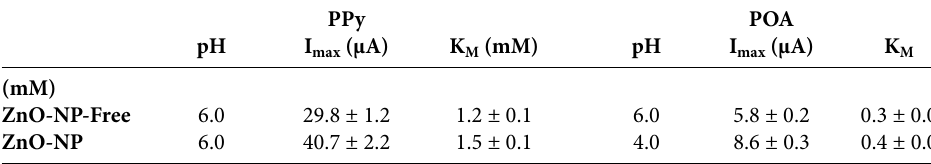
Table 1. Kinetic parameters and optimal pH values of GOD electrodes with and without ZnONP PPy